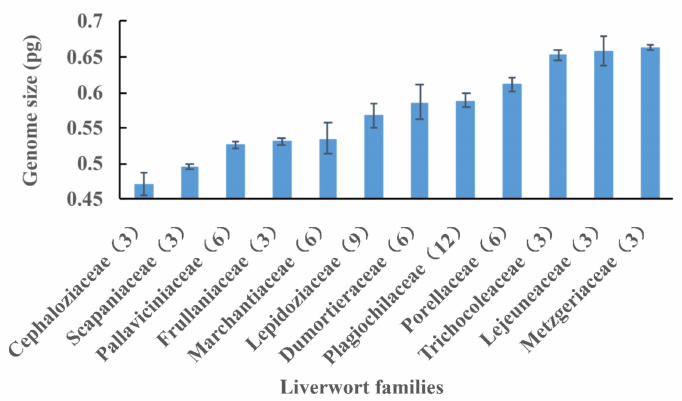
Figure 1. Mean values and standard errors (bars) of DNA 1C values for 32 moss families. Sample number is listed in parentheses.